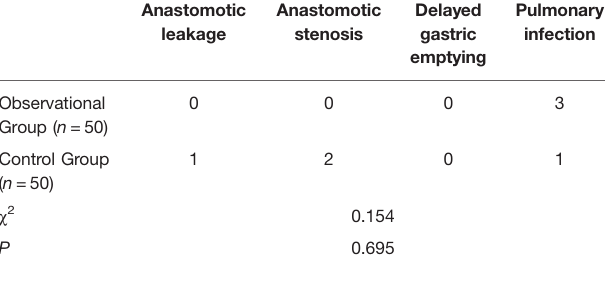
TABLE 3 | The incidence of anastomotic leakage, anastomotic stenosis, delayed gastric emptying, and pulmonary infection in different groups.